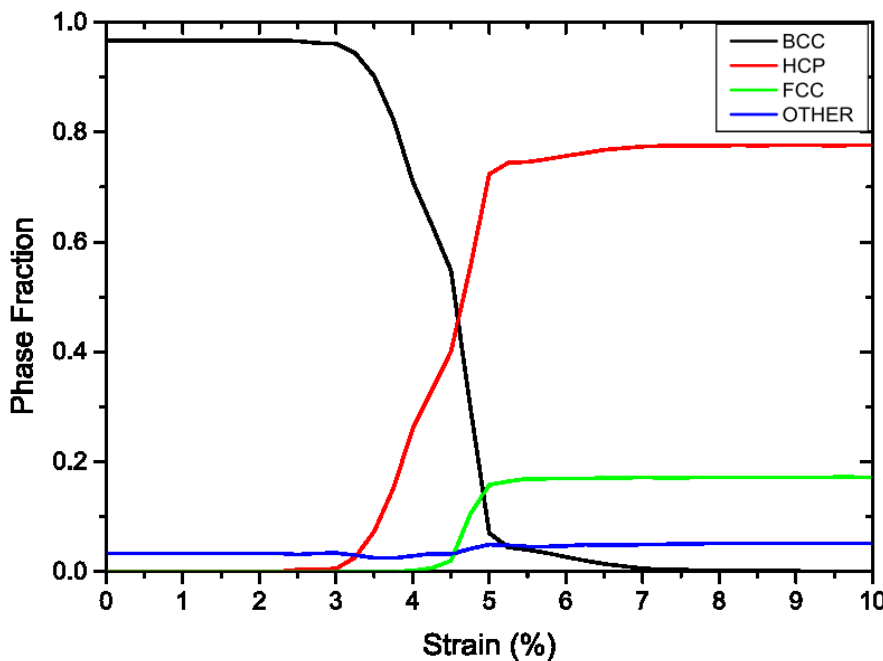
Figure 8. Phase fraction versus strain of a single-crystal containing four coherent twin boundaries under hydrostatic compression with a strain rate of 1 × 10 9 s − 1 .